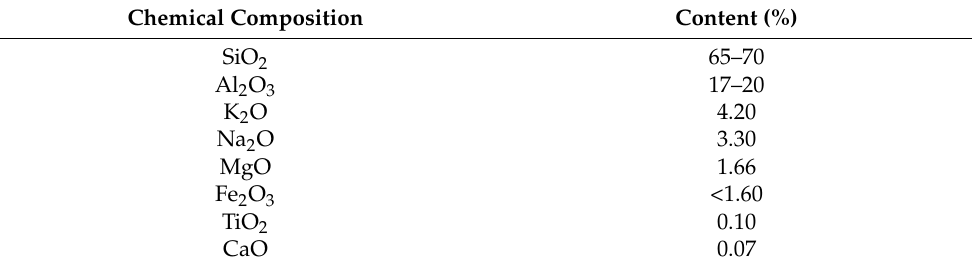
Table 1. Chemical compositions of kaolin.